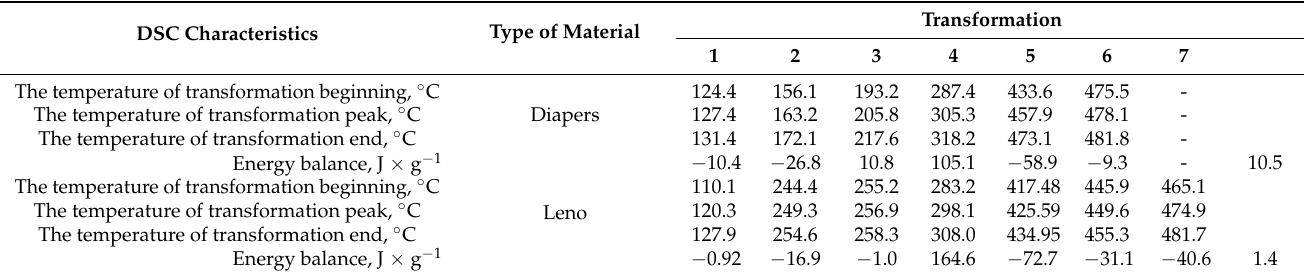
Table 7. Normalized transformation energy for successive transformations of tested hygiene waste and energy balance of the process. DSC Characteristics The temperature of transformation beginning, ◦